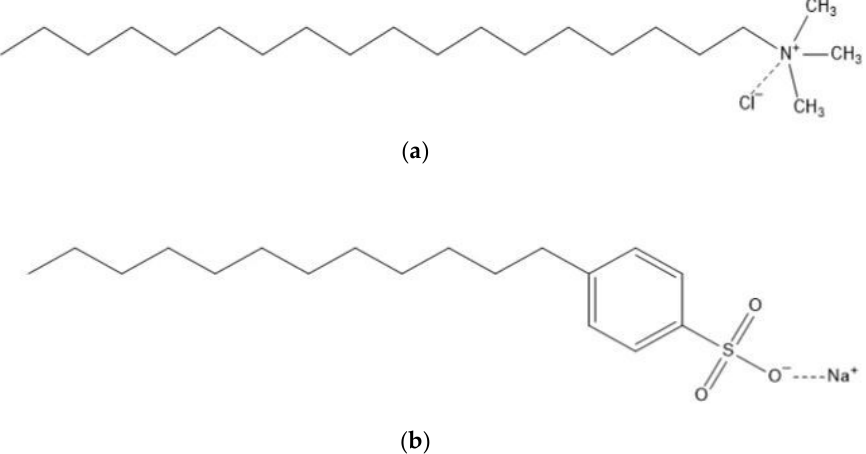
Figure 1. ( a ) STAC molecular structure; ( b ) SDBS molecular structure.